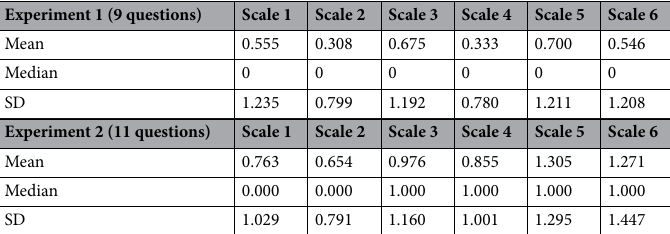
Table 4. Number of responses that correspond with number labels of Scales 5 and